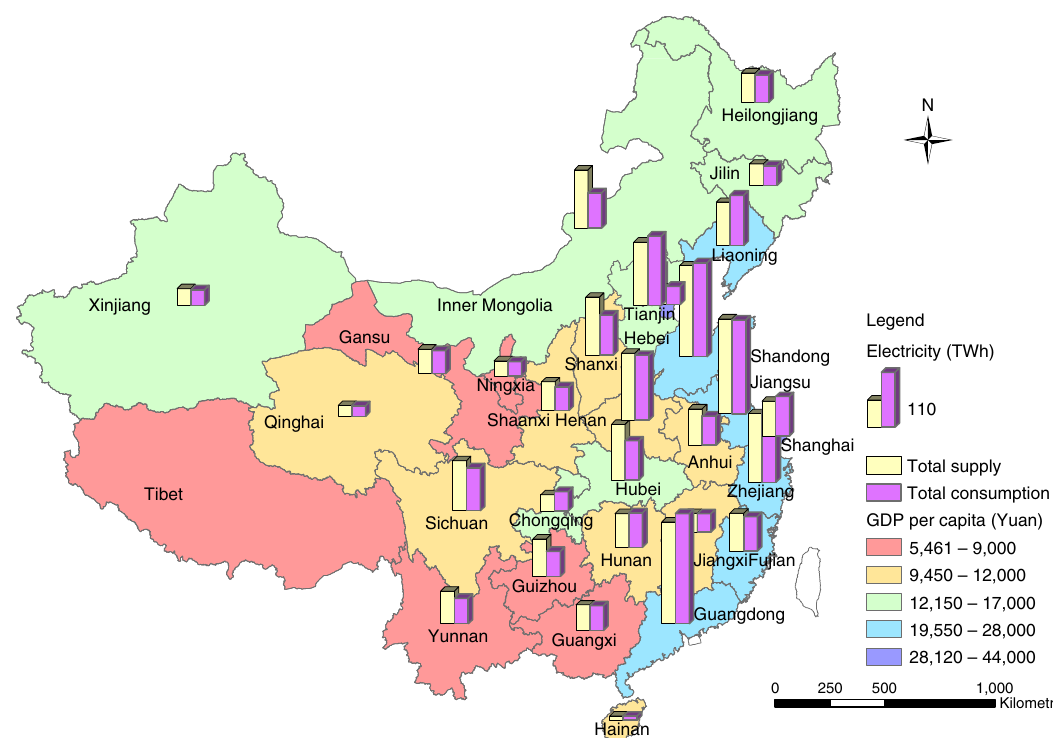
Figure 1 | Variations in electricity use and economic conditions in China. The map shows the electricity generation and consumption, and GDP per capita across all 30 provinces and municipalities of mainland China (excluding Tibet) in the year of 2014. Around one-third of the coal electricity in China is generated by the power plants located right near large coal mines in the northern and western provinces 4 , whereas over 40% of the electricity is consumed by the major industrial and urban centres in the coastal provinces, which account for about half of the national GDP and industrial output.